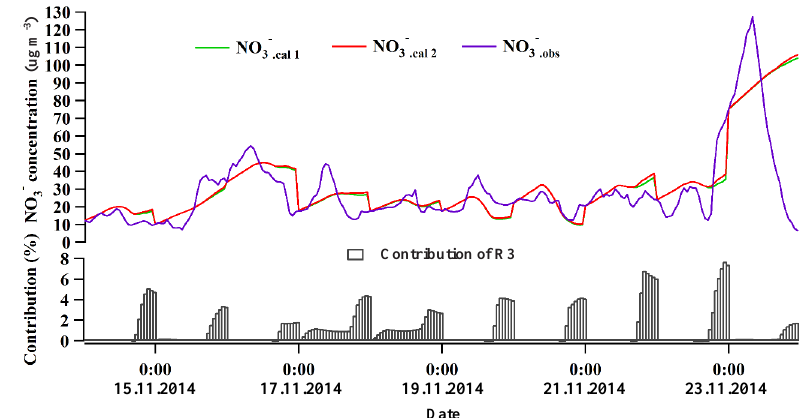
Figure 11. Comparison of NO − between theoretical calculations and observation in episode 6. 3